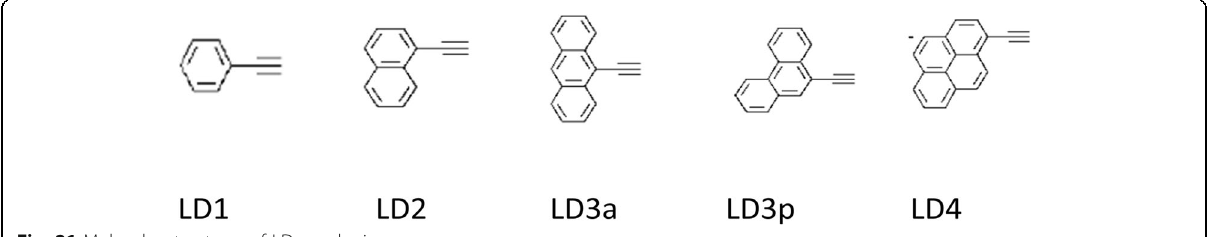
Fig. 21 Molecular structures of LD